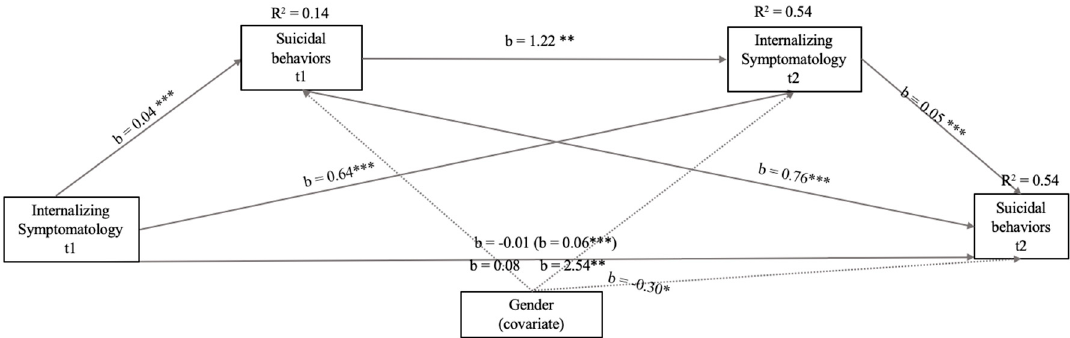
Figure 2. Model of mediation of the relations between Internalizing Symptomatology (t1 and t2) and Suicide Behaviors (t1) with Suicide Behaviors (t2) after controlling for gender (girl). In this statistical diagram, values are represented with non-standardized regression coefficients. In the association between Internalizing Symptomatology t1 and Suicide Behaviors t2, the value outside parentheses represents the direct effect, and the value in parentheses represents the total effect of the bootstrapping analysis of Internalizing Symptomatology t1 on Suicide Behaviors t2 after the inclusion of the mediation variables. *** p < 0.001, ** p < 0.01, * p < 0.05.